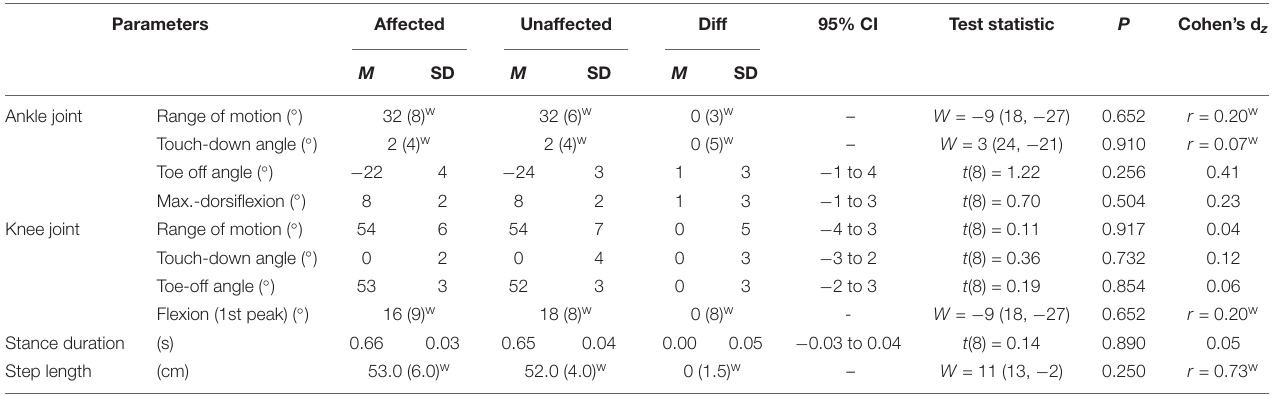
TABLE 1 | Leg kinematics and spatio-temporal parameters during walking stance. Parameters